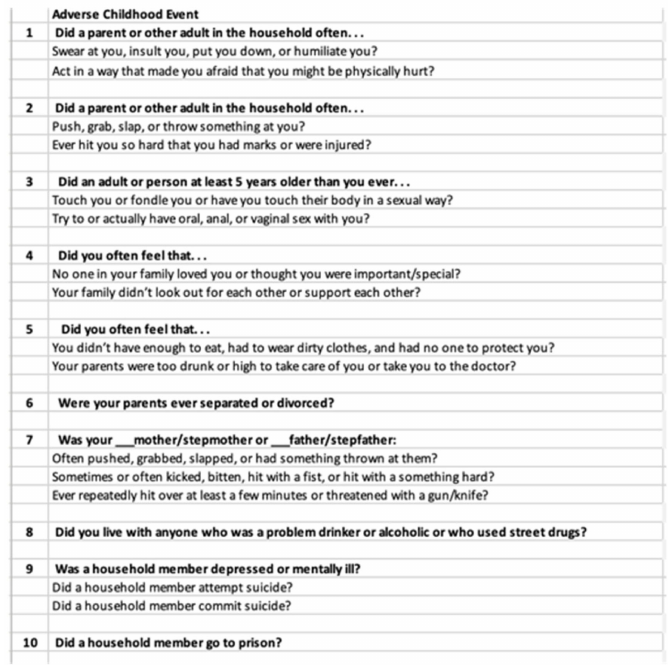
Figure A1. Adverse Childhood Events for the Townsend